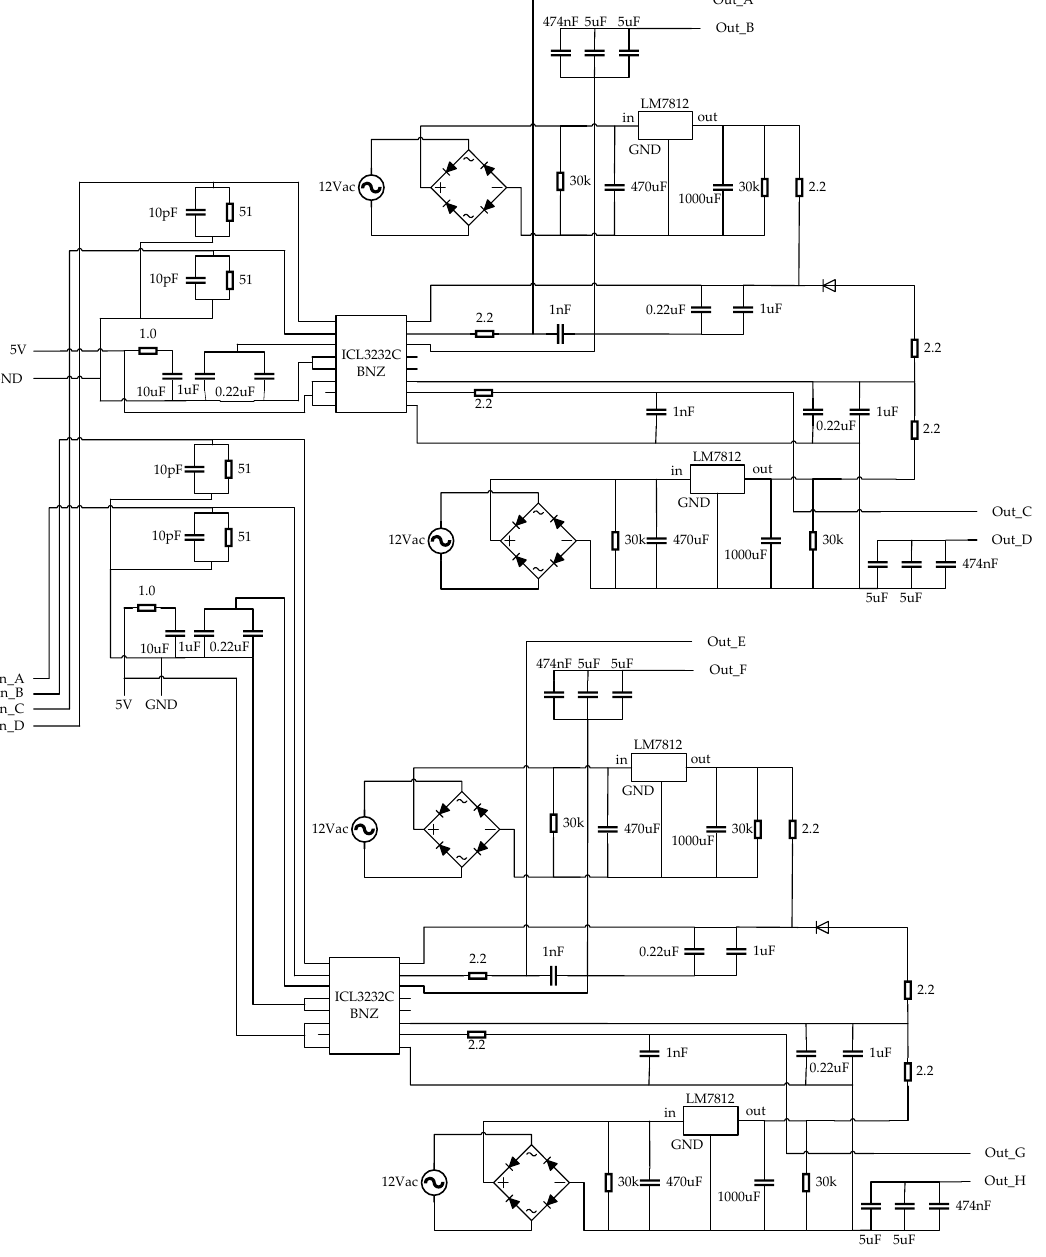
Figure 5. The circuit driving the current to the electronic switching.